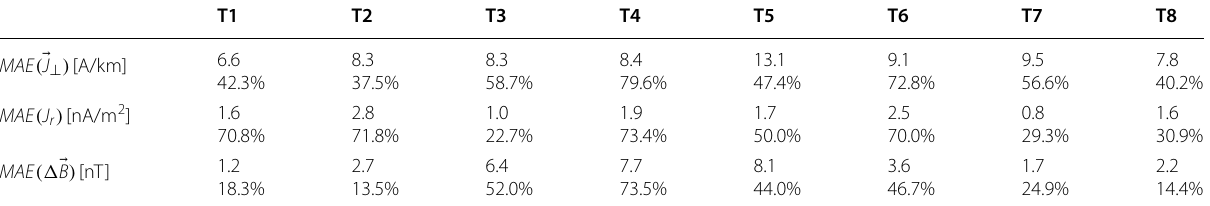
Table 2 Absolute (upper numbers) and relative (lower numbers) mean absolute errors in the 8 synthetic test cases, calculated at one longitude between the Swarm-A/C satellites T1 T2 T3